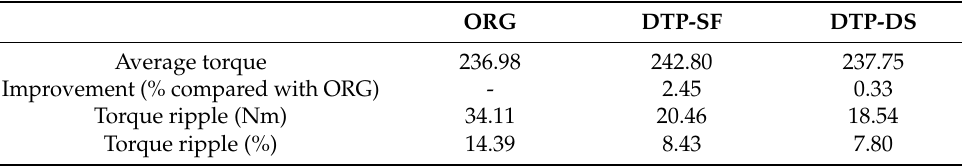
Figure 24. Instantaneous torque performance of different winding configurations under maximum torque condition: ( a ) waveforms; ( b ) spectra. Table 6. Comparison of instantaneous torque performance of different winding configurations under maximum torque condition.